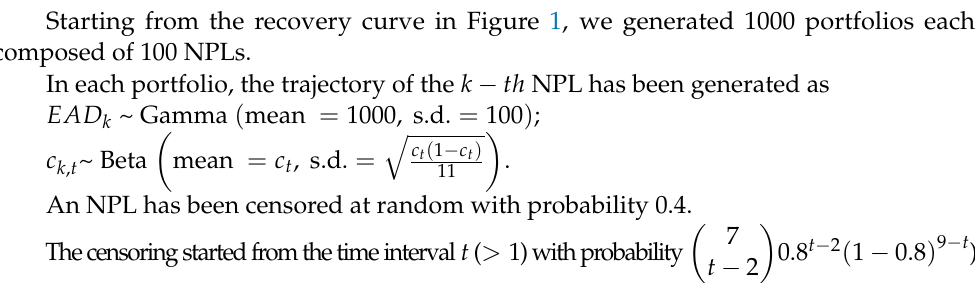
Figure 1. Recovery curve with T = 9, expressed both in terms of recovery rate ( r t ) and conditional recovery rate ( c t ).